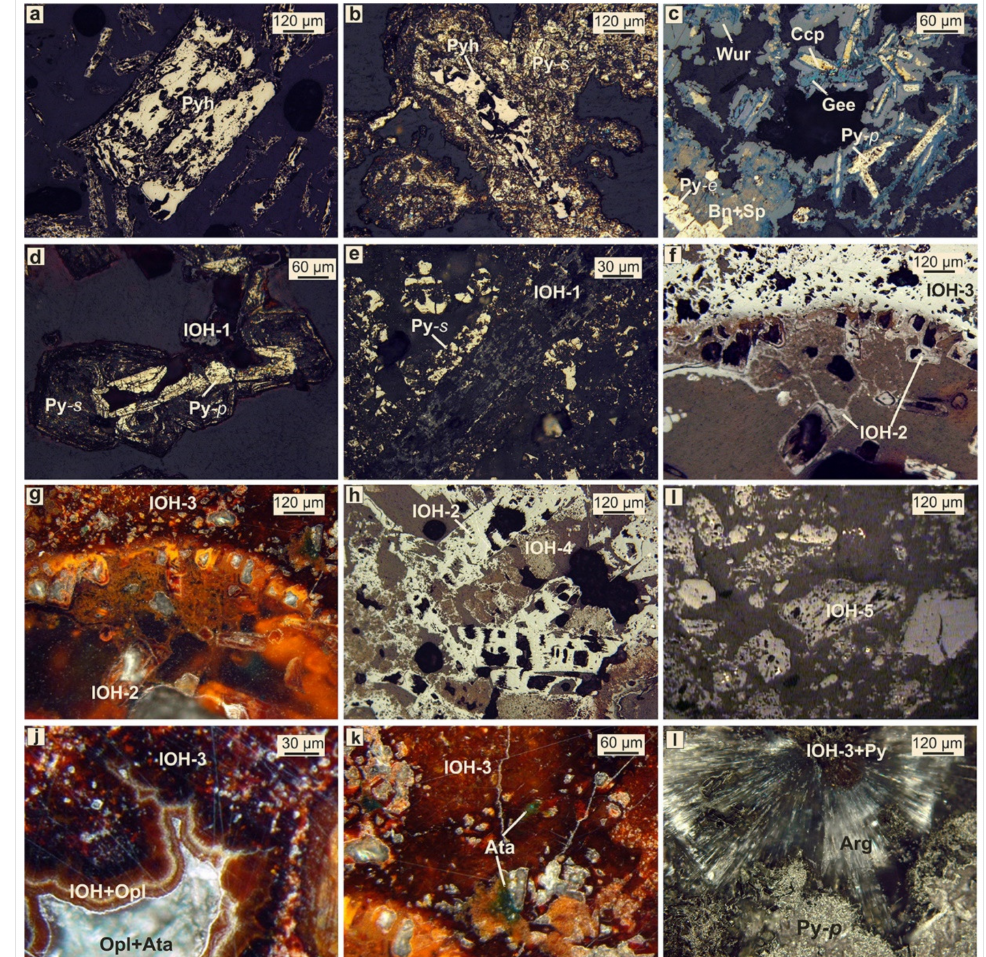
Figure 2. Morphology of pyrrhotite, (Pyh), pyrite (Py) and IOHs of the Pobeda-1 hydrothermal field: ( a ) Euhedral pyrrhotite crystal; ( b ) Relict pyrrhotite crystal replaced by secondary pyrite (Py- s ); ( c ) Pseudomorphic pyrite (Py- p ) and chalcopyrite (Ccp) after subhedral pyrrhotite crystals overgrown by wurtzite (Wur) with bornite–sphalerite–geerite (Bn+Sp, Gee) assemblage; ( d ) Pseudomorphic boxy pyrite after pyrrhotite crystals (Py- p ) replaced by IOHs; ( e ) Immature poorly crystalline pseu- domorphic IOH-1 after pyrrhotite crystal; ( f ) Crystalline pseudomorphs after subhedral pyrrhotite (IOH-2) and after massive pyrite–pyrrhotite aggregates (IOH-3) in the wall of the conduit; ( g ) The same in dark field view; ( h ) Interstitial dark porous IOH-4 aggregates between IOH-2 pseudomorphs after subhedral pyrrhotite crystals; ( i ) Clastic IOH-5 with relict pyrite inclusions; ( j ) Opal (Op+Ata) in IOH-3; ( k ) Atacamite (Ata) in IOH-3; ( l ) Aragonite (Arg) in assemblage with pyrite and minor IOHs. Reflected light ( a – f , h , i ); dark field images ( g , j – l